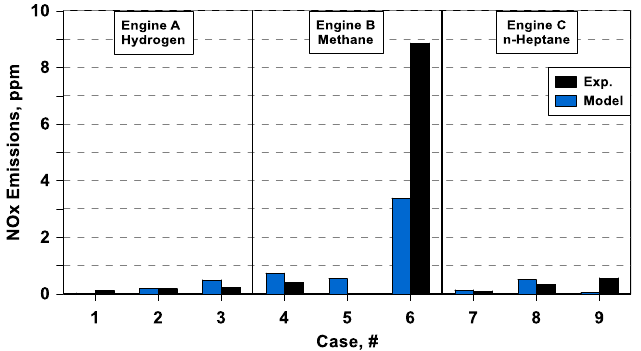
Figure 16. Numerical/experimental comparison of engine-out NOx emissions for Engines A, B, and C.